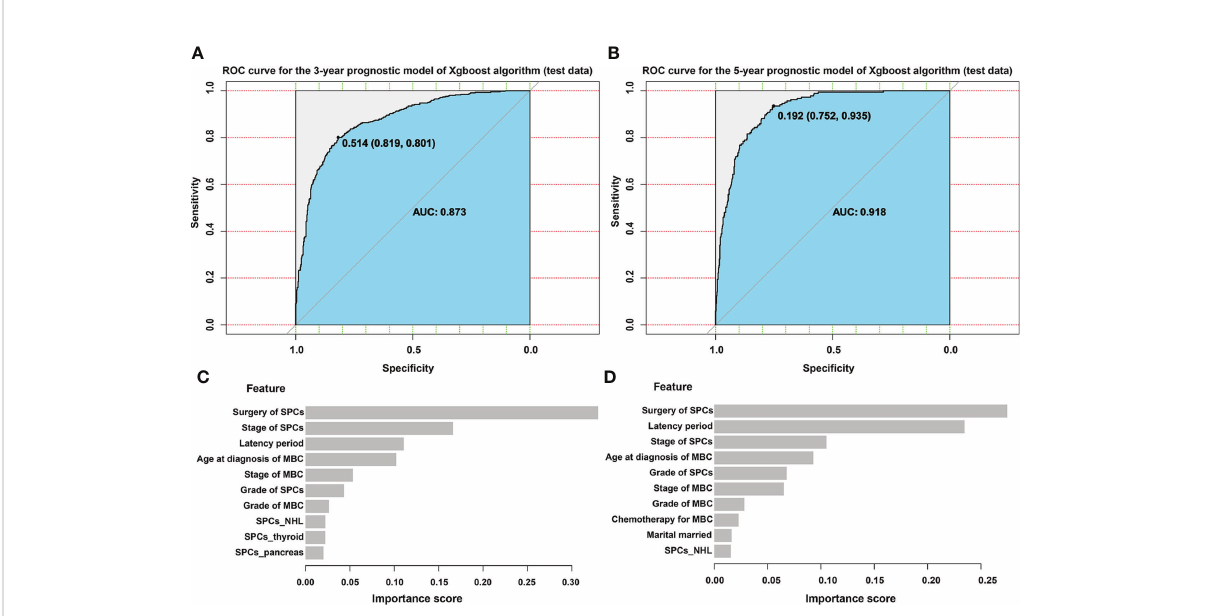
FIGURE 6 XGBoost model evaluationROC: receiver operating characteristic curve; AUC: area under the curve (A) ROC curve for the 3-year prognostic model of XGBoost algorithm (test data), (B) ROC curve for the 5-year prognostic model of XGBoost algorithm (test data), (C) The ranking of clinical characteristics in terms of importance in the 3-year prognostic model. The x-axis of the graph is the feature importance score. The closer the score is to 1, the more important the feature in predicting the prognosis of the patient in the model. (D) The ranking of clinical characteristics in terms of importance in the 5-year prognostic model. The x-axis of the graph is the feature importance score. The closer the score is to 1, the more important the feature in predicting the prognosis of the patient in the model.